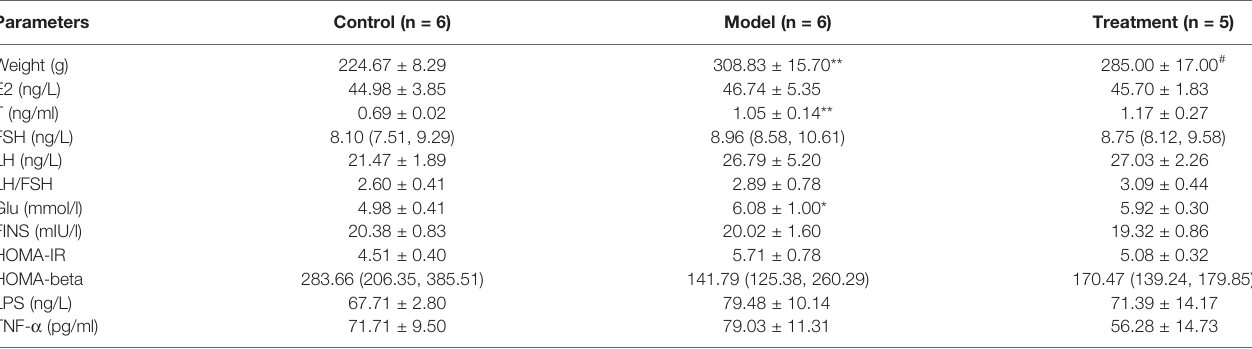
Data are presented as mean ± SD or as medians with interquartile ranges.